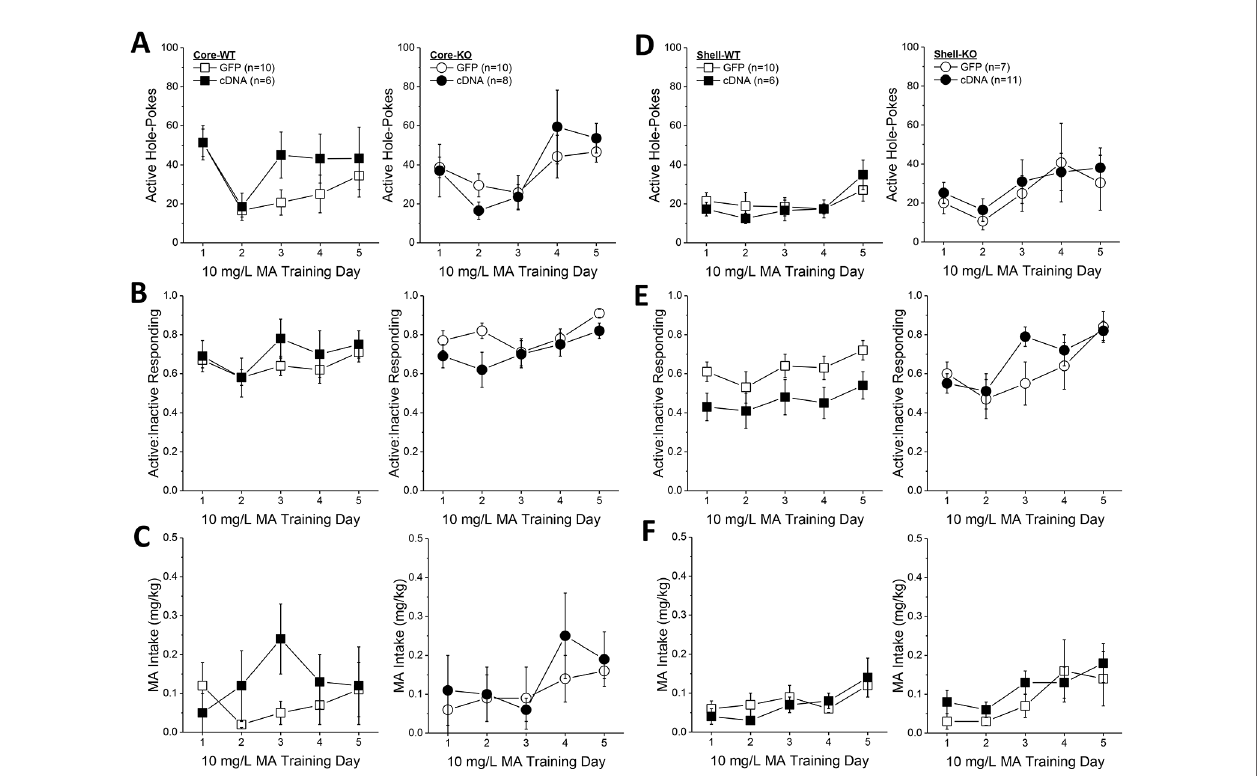
FIGURE 6 | Homer2b overexpression does not alter methamphetamine (MA) reinforcement and intake during early training for MA self-administration. When compared to WT (left) and Homer2 knockout (KO) (right) mice infused with green fl uorescent protein (GFP), cDNA infusion into the nucleus accumbens (NAC) core did not alter: (A) active hole responding, (B) response allocation or (C) MA intake during the fi rst 5 days of self-administration training. (D – F) Similarly, cDNA infusion into the NAC shell did not affect any measure of self-administration during early training. The data represent the means ± SEMs of the number of mice indicated in Panel A (NAC core) and Panel D (NAC